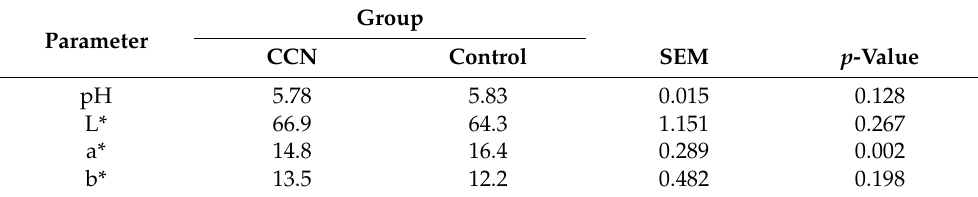
Table 4. pH and color parameters of breast muscle of male broiler